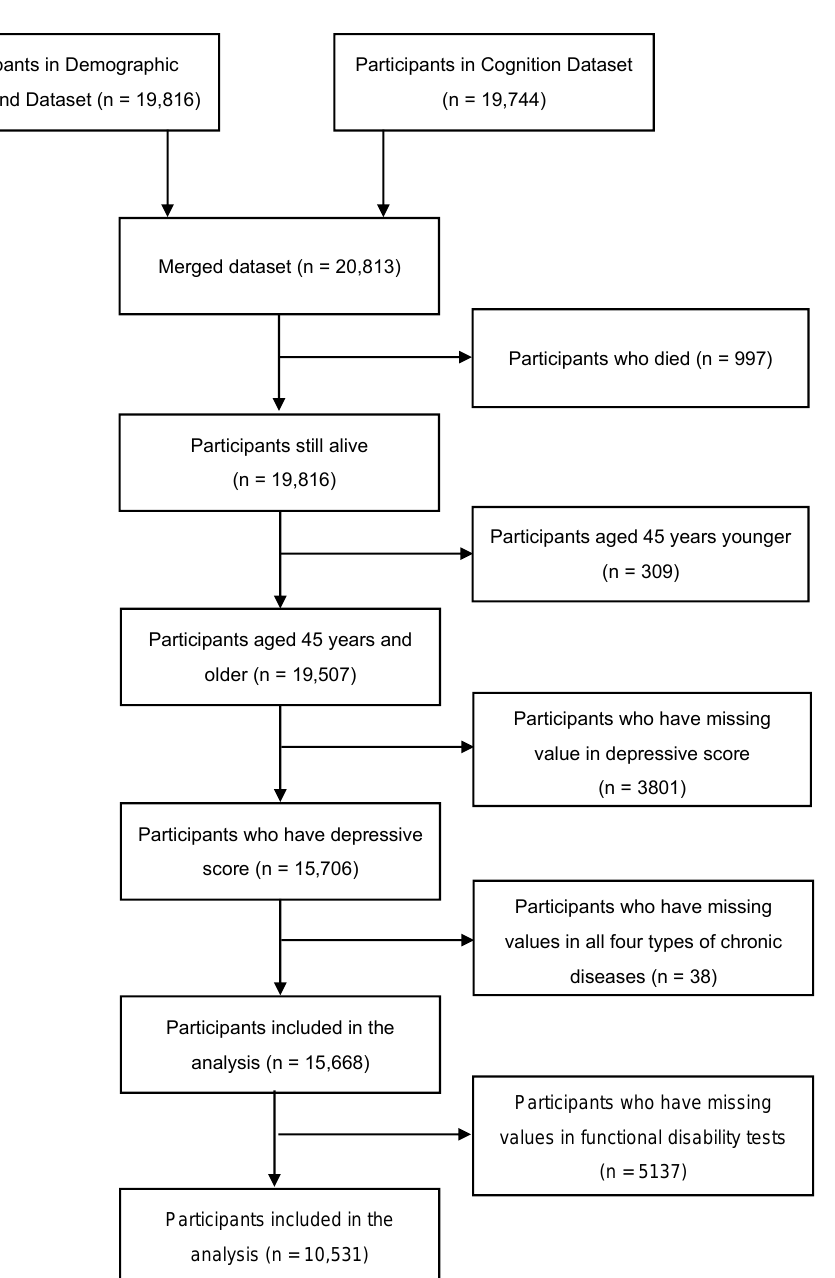
Figure 1. Inclusion process of the participants.